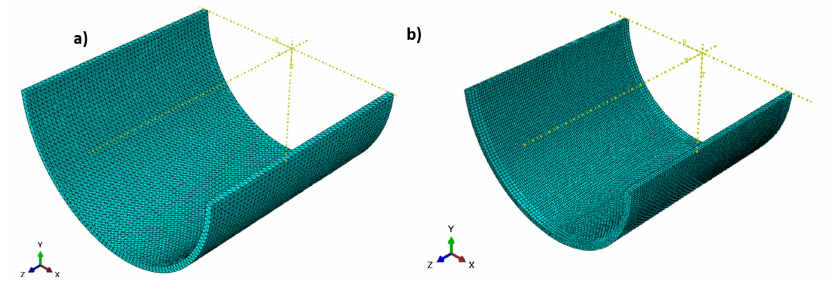
Figure 3. FE mesh ( a ) tetrahedron shape (un-notched), ( b ) hexagonal shape